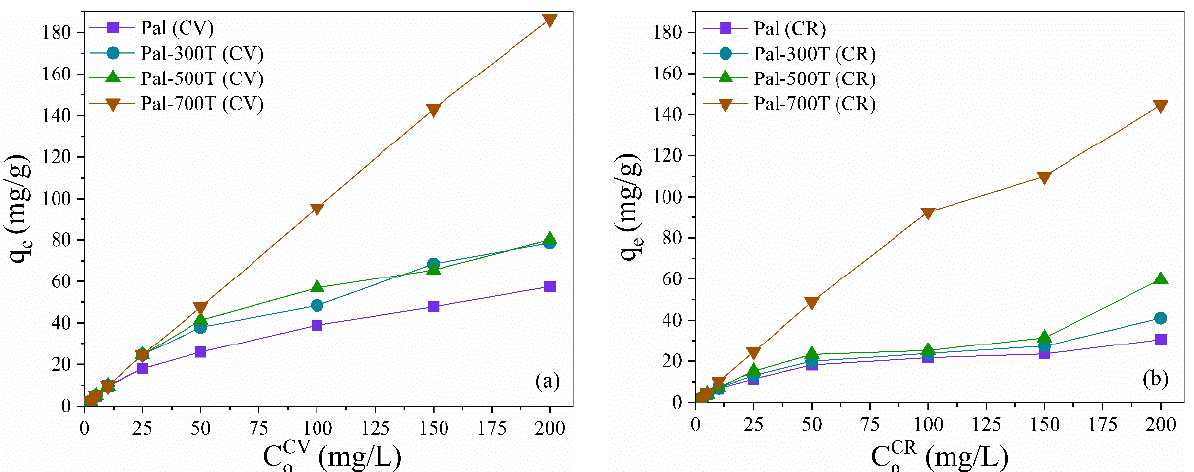
Figure 3. Effect of initial concentration on the adsorption capacity of natural and heat-treated palygorskite to remove ( a ) CV and ( b ) CR.